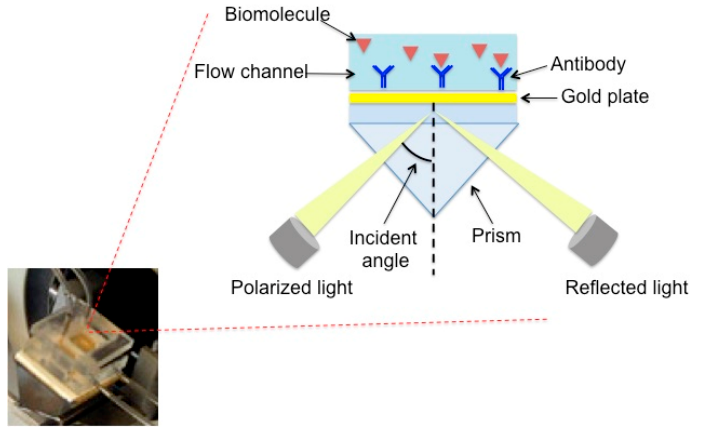
Figure 1. Measurement device used for surface plasmon resonance (SPR) operating in flow